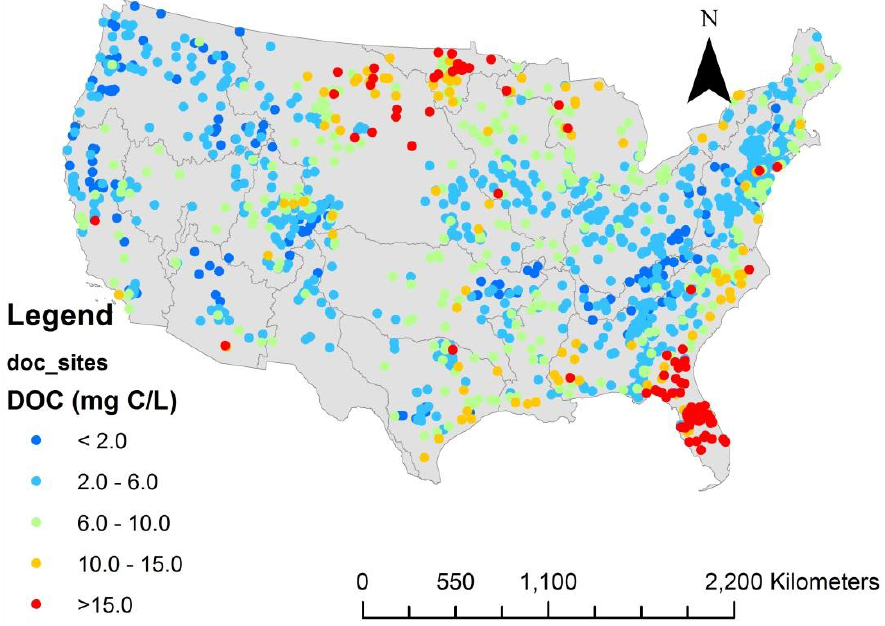
Figure 1. Dissolved organic carbon (DOC) concentrations across selected United States Geological Survey (USGS) gauges.